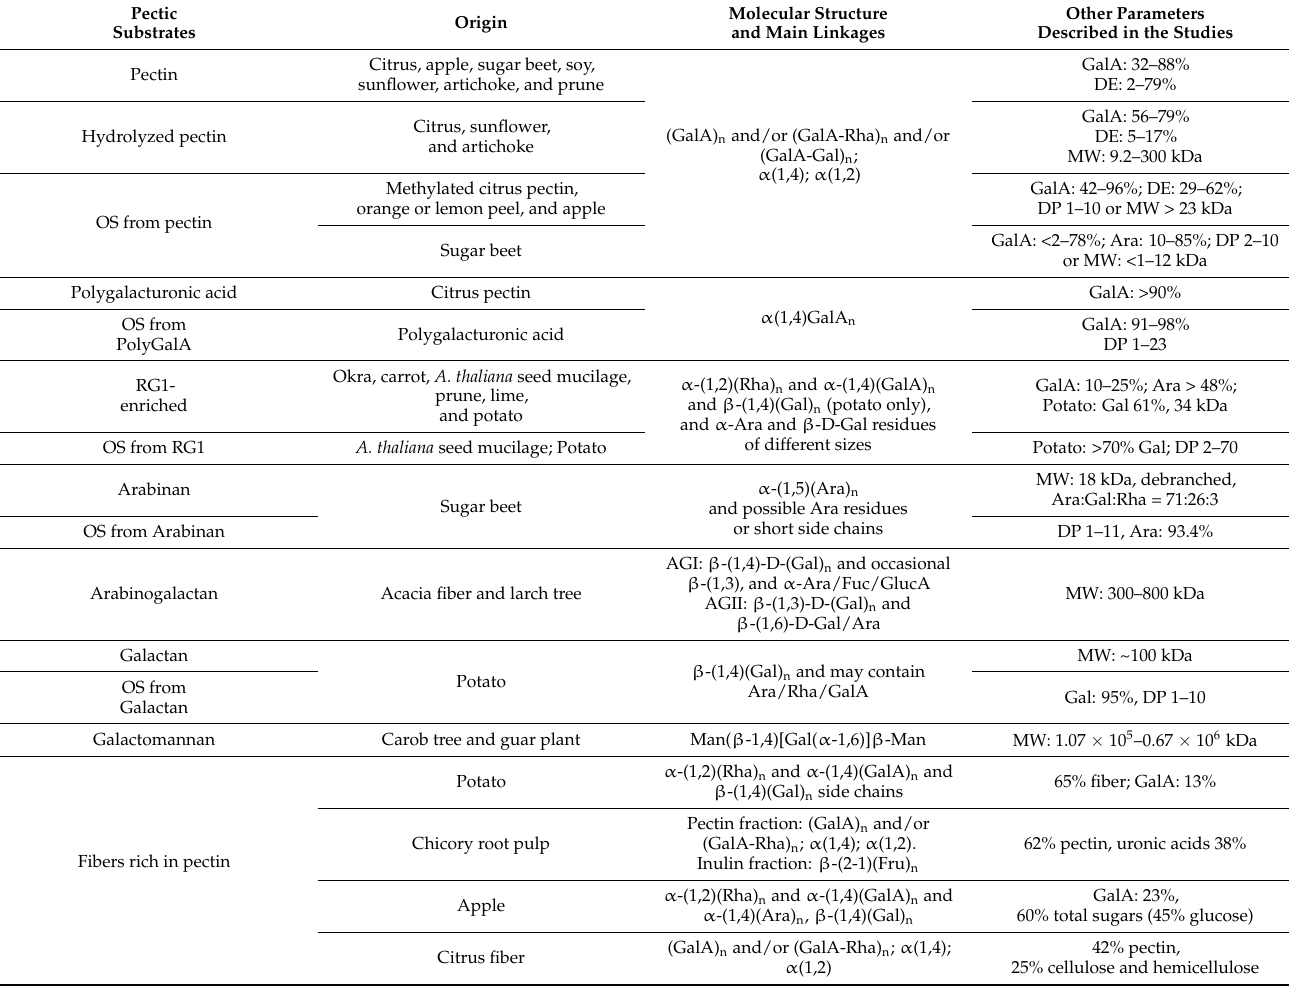
Table 1. Description of the various structures of pectic substrates used in the studies.